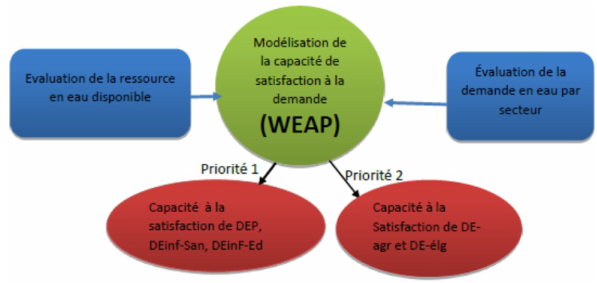
Figure 3. Modélisation avec le logiciel WEAP (Rakotoarisoa,